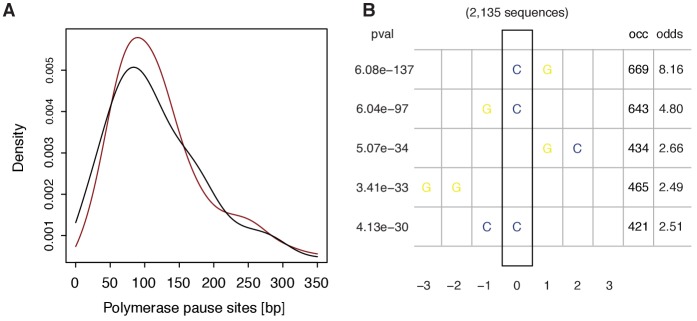
Features of underlying DNA sequence around promoter-proximal pause sites.(A) Distributions of pause site depicted as densities for TUs with a response ratio >75% quantile (574 TUs, red) and TUs with a response ratio <25% quantile (469 TUs, black). (B) Plot showing the top 5 enriched 2-mers found by comparing the frequency of all possible 2-mers in a window of ±10 bp around the estimated pause site for fixed positions. Testing was done via Fisher’s exact test against the (background) frequency of the respective 2-mer obtained from a window of the same size shifted 500 bp downstream. The respective p-values and odd-ratios are given in the left and right panel.